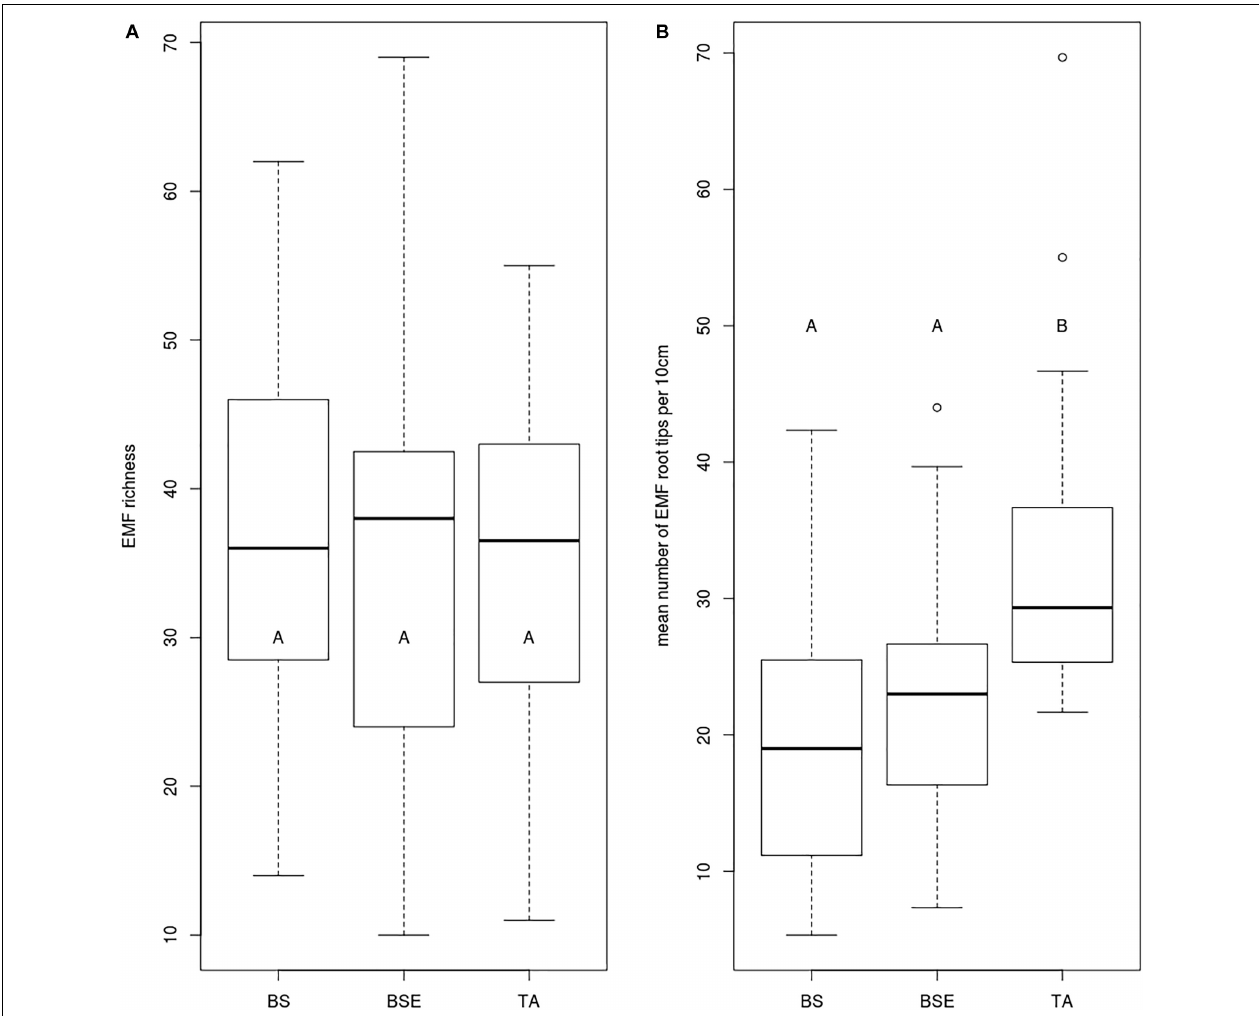
FIGURE 3 | Boxplot charts showing (A) EMF richness and (B) number of EMF root tips per 10 cm roots of BF saplings sampled in different stands. BS, black spruce; BSE, black spruce plus ericaceous shrubs; TA, trembling aspen. Different letters indicate differences between